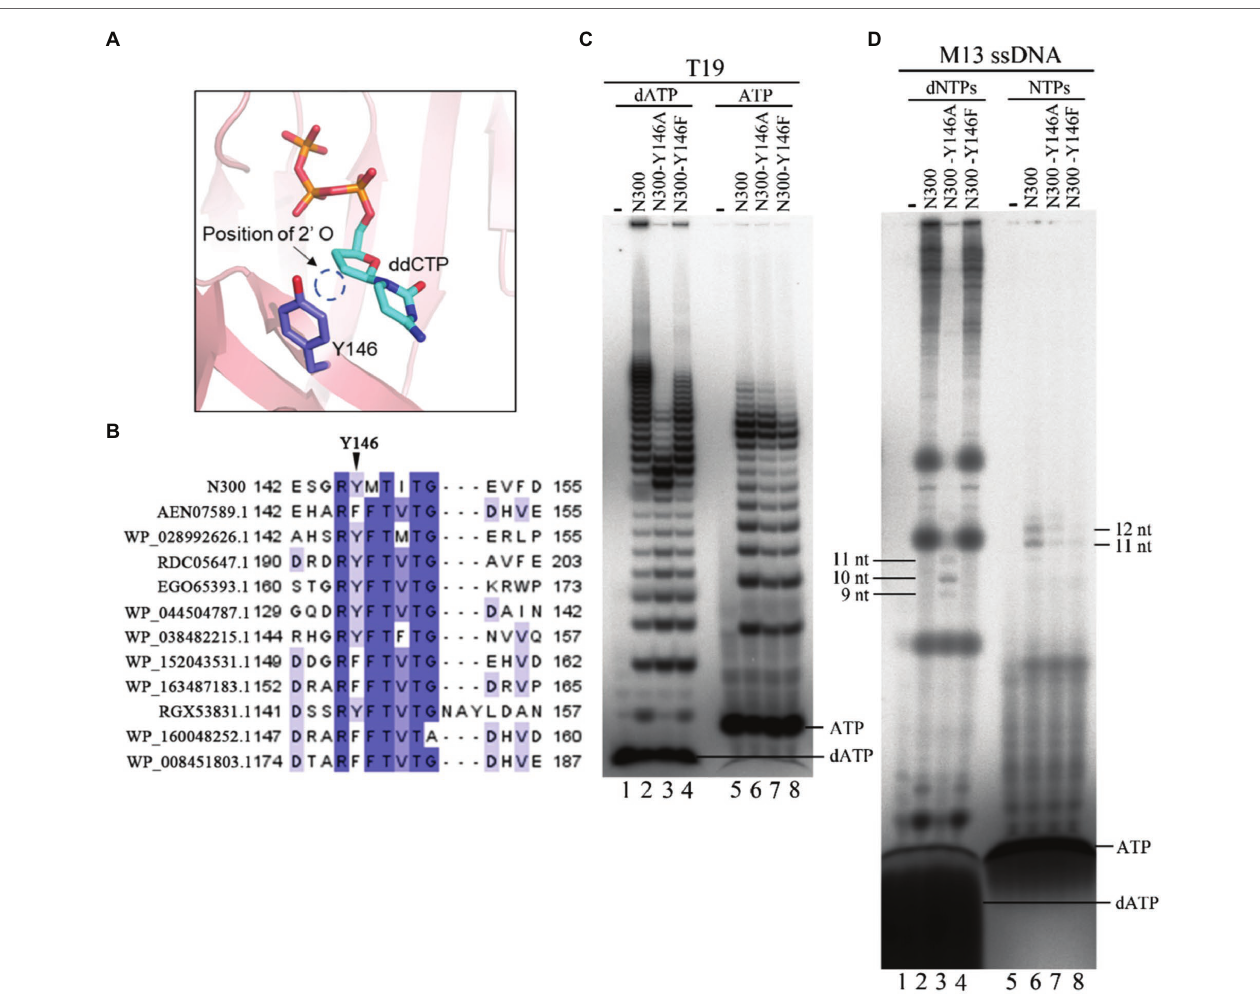
FIGURE 7 | Effects of Y146 mutations in N300 on catalytic activity. (A) Detailed interaction between Y146 and the ribose of ddCTP. (B) Alignment of Y146 of N300 and equivalent positions to Y146 of N300 orthologs. (C) DNA primer synthesis (lanes 1–4) and RNA primer synthesis (lanes 5–8) on the template T19 [5 ' -(T) 14 TTGTGGTT-3 ' ]. Reactions were incubated for 30 min at 50 ° C in the presence of either dATP and [ α - 32 P] dATP (lanes 1–4) or ATP and [ α - 32 P] ATP (lanes 5–8). The products were separated on a 3 M urea-25% PAGE. (D) DNA synthesis (lanes 1–4) and RNA synthesis (lanes 5–8) on the M13 ssDNA. Reactions were incubated for 30 min at 50 ° C in the presence of either dNTPs and [ α - 32 P] dATP (lanes 1–4) or NTPs and [ α - 32 P] ATP (lanes 5–8). The products were separated on an 8 M urea-20% PAGE. Data in the figure are representative of at least two independent